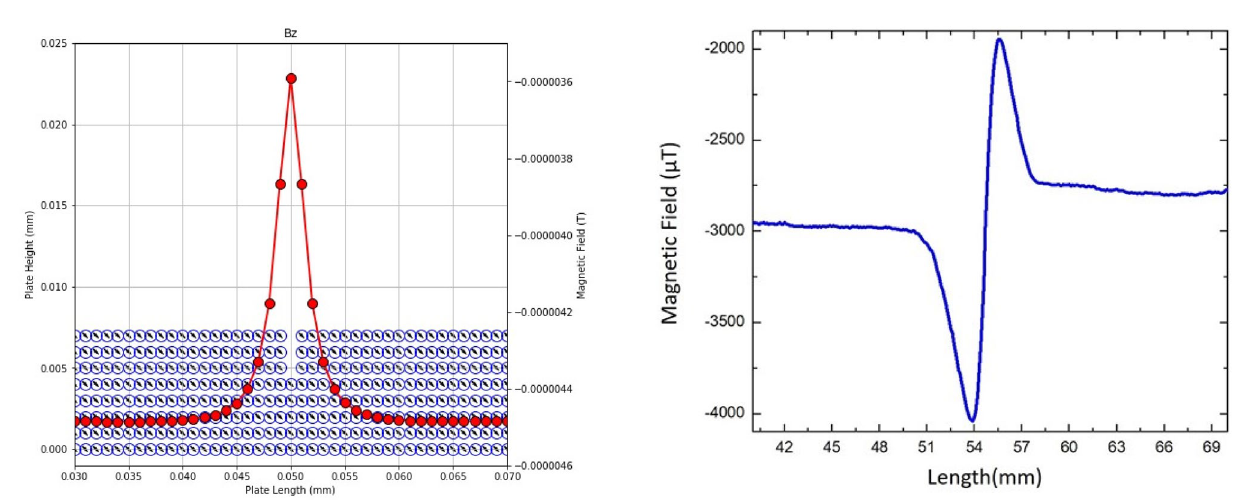
Fig. 10 Magnetic field Z of a rectangular defect with ordered mag- netic domains